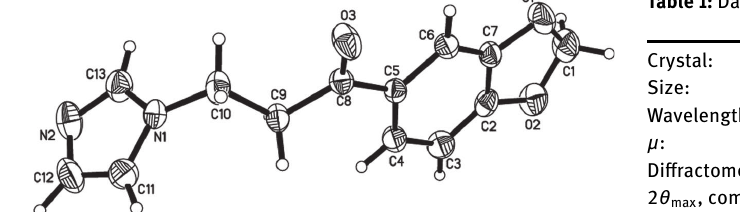
Table 1: Data collection and